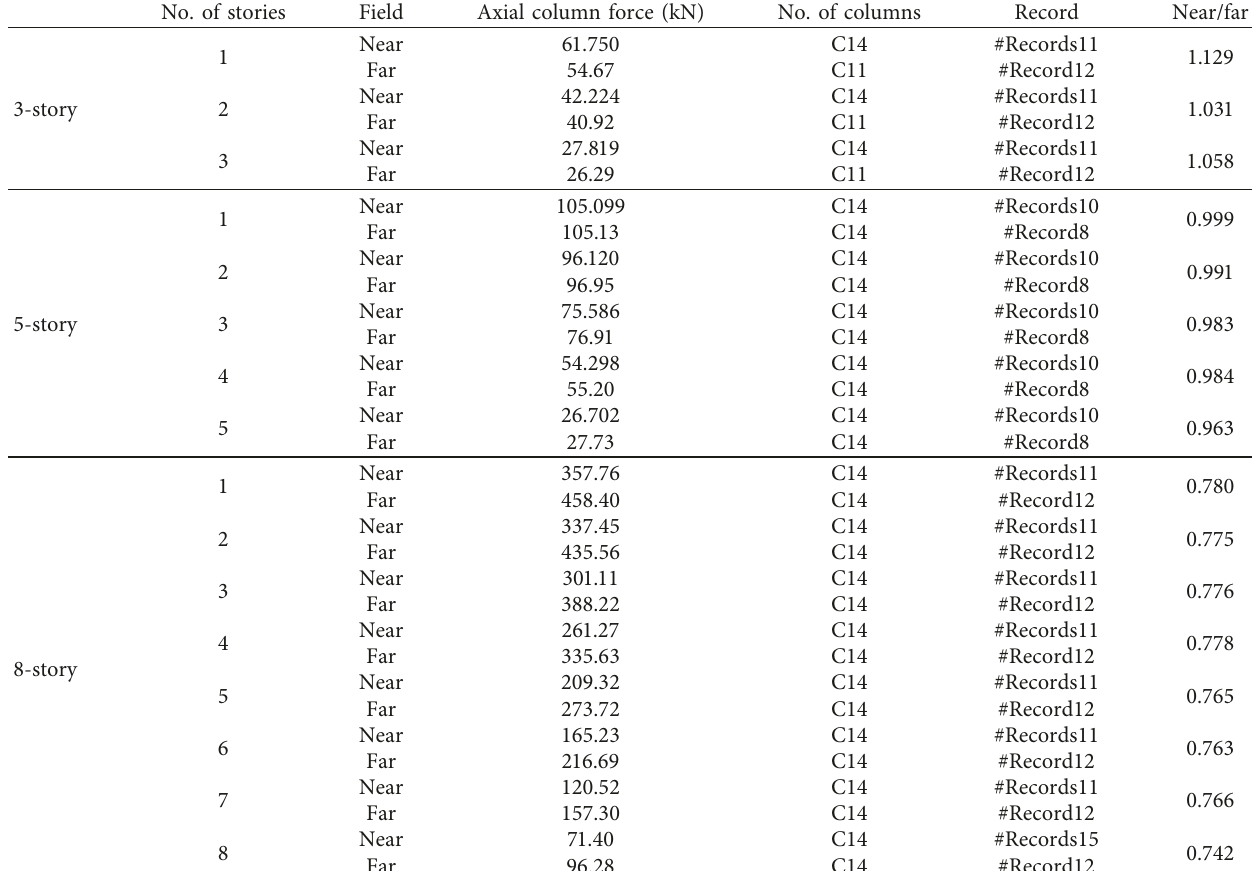
Table 5: Comparison of the maximum axial force of columns in 3-, 5-, 8-, and 20-story buildings subjected to near- and far-field